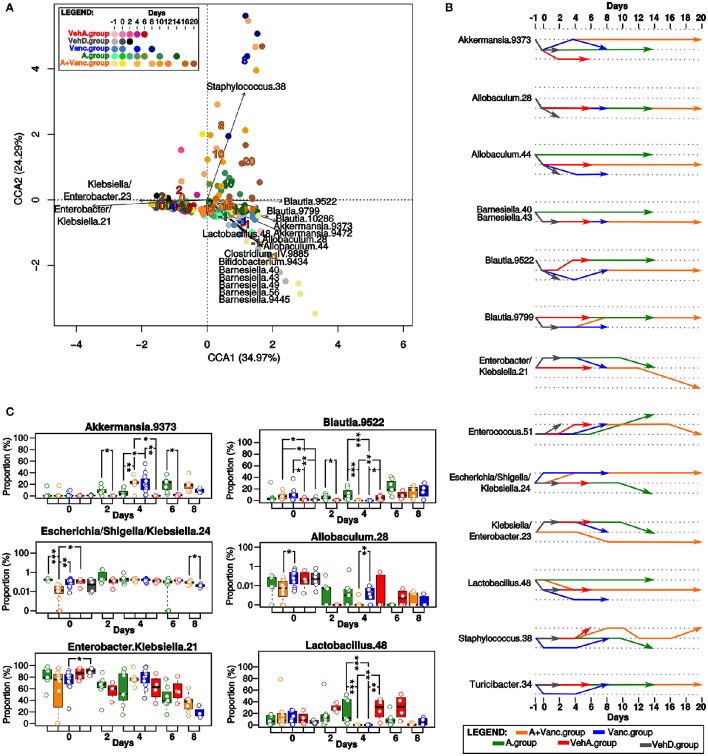
Microbial composition of the experimental groups. (A) The canonical correspondence analysis (CCA). The time-points of the experimental groups had significant influence on the microbial composition. Each dot represents the total microbial composition of one sample. The names of bacterial OTUs with the significant influence (p < 0.01) on the ordination of samples in this CCA plot are shown, it was mostly driven by tree bacterial groups (Klebsiella/Enterobacter, Blautia/Akkermansia/Allobaculum/Lactobacillus/Barnesiella, and Staphylococcus). The numbers in the CCA plot refer to the collected days, they are colored according to the experimental group colors (red, gray, blue, green, orange) and their coordinates in the plot are given by the direction of their influence on the ordination of the samples. (B) Longitudinal comparison of the proportion of bacterial OTUs in pairs of two consecutive time-points. The increasing/decreasing direction of the arrows mean that the proportion of that particular OTU had significant (p < 0.05) fold-change increase/decrease between the inquired consecutive time-points. The most important changes in bacterial proportions occurred on the days 0 and 4 corresponding to the treatment changes. (C) Comparison of the OTUs proportions in the common time-points of the experimental groups. Significant differences are marked by asterisks (*p < 0.05, **p < 0.01, ***p < 0.001), box-plot colors refer to the experimental groups. The most important differences between groups were detected on day 0 and 4.